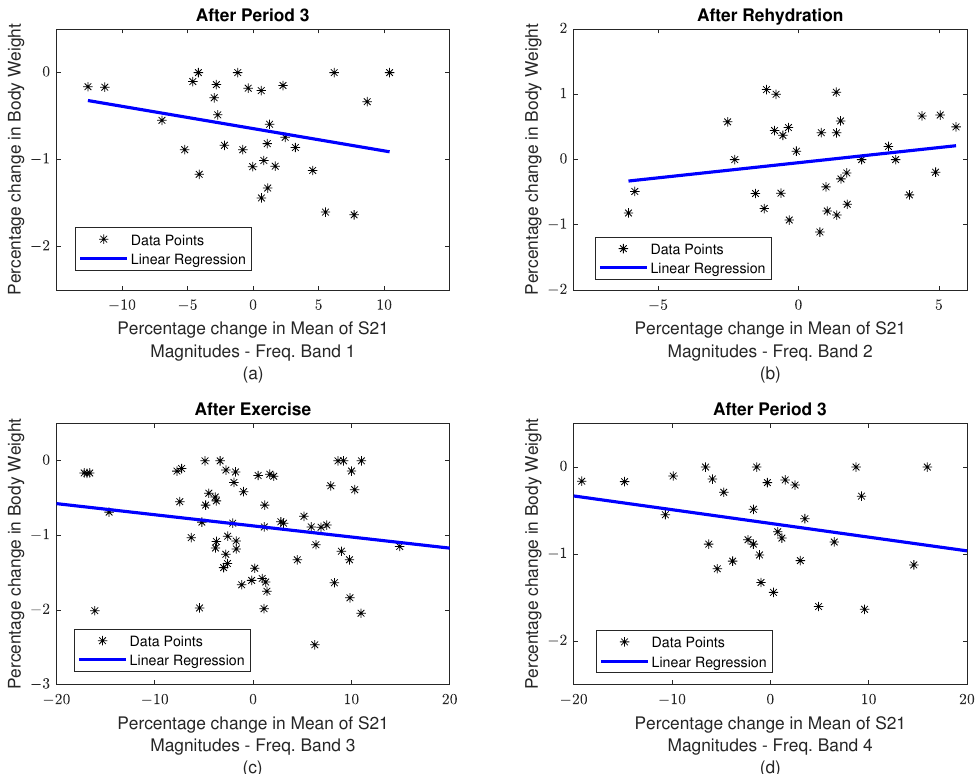
Figure 8. Correlation plots for selected cases. Percentage changes in ( a ): body weight vs. mean of S21 magnitudes in frequency band 1 during the measurement time "After Period 3"; ( b ): body weight vs. mean of S21 magnitudes in frequency band 2 during the measurement time "After Rehydration"; ( c ): body weight vs. mean of S21 magnitudes in frequency band 3 during the measurement time "After Exercise"; ( d ): body weight vs. mean of S21 magnitudes in frequency band 4 during the measurement time "After Period